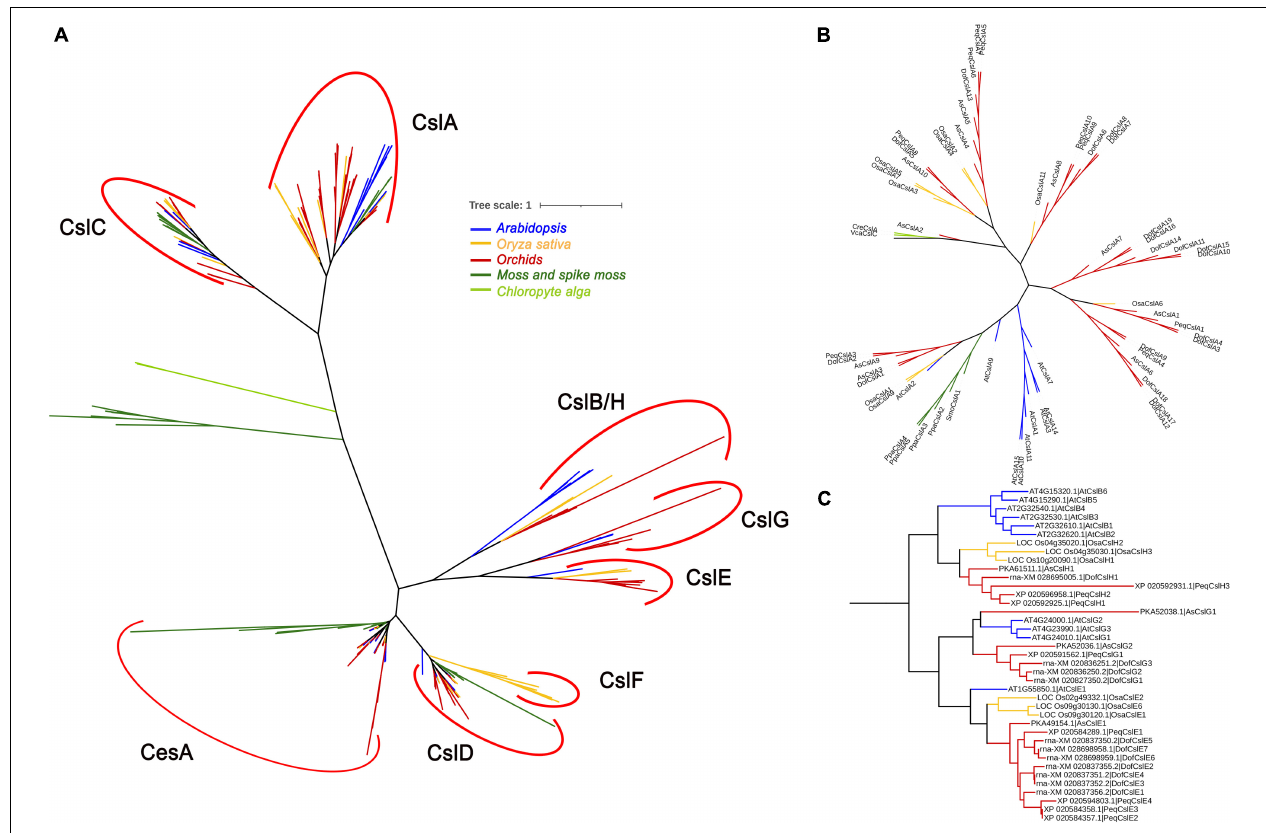
FIGURE 2 | Phylogenetic relationships between Cellulose synthase proteins from nine representative species: two chlorophyte algae (light green), a moss and spike moss (dark green), three orchid species (red), rice (yellow), and Arabidopsis (blue). The CesA/Csl proteins were grouped into nine families: CesA, CslA, CslB, CslC, CslD, CslE, CslF, CslG, and CslH. (A) The phylogenetic tree contains all 273 CesA/Csl protein sequences; (B) phylogenetic tree showing only the CslA cluster; (C) phylogenetic tree showing only the CslB/H/E/G cluster. The sequences in (B,C) were extracted from (A) and